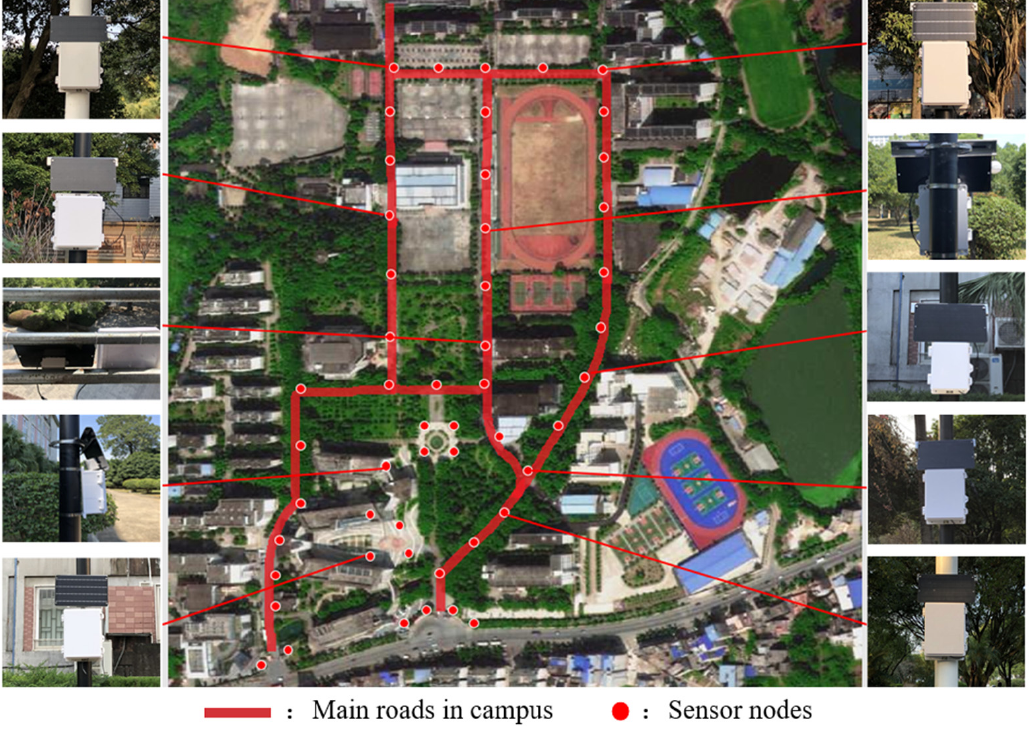
Figure 10. Example of the place where the sensor nodes are being deployed.